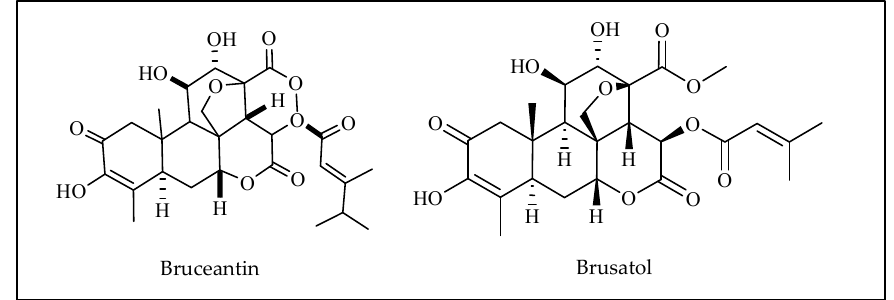
Figure 16. Bruceantin and brusatol.